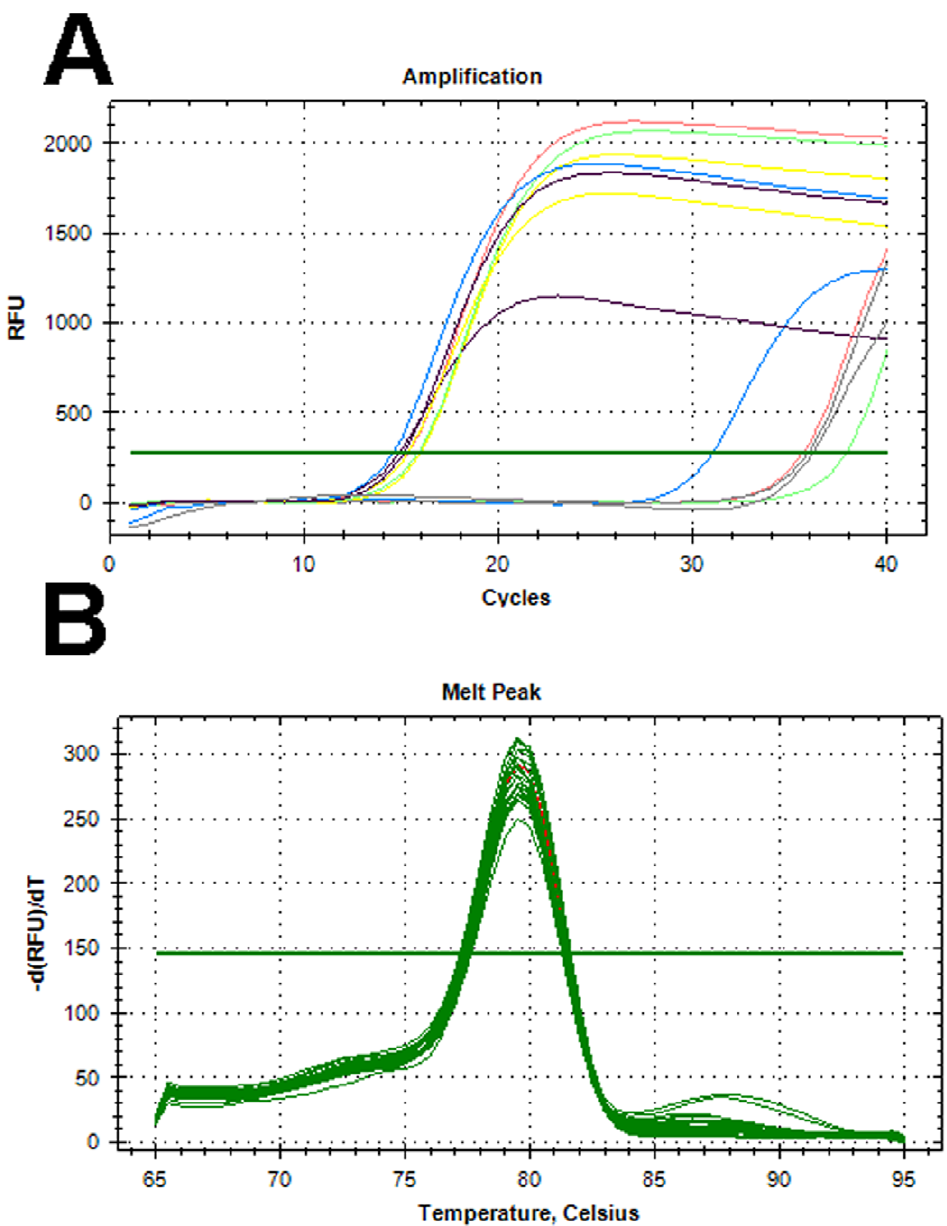
Figure 1. Amplification and melting curves for selected isolates. ( A ) Amplification curves of three of the eight E. coli isolates that were uidA - negative, but yccT -positive; MRSN 1628 (Red line), MRSN 1681 (Blue Line), and MRSN 7544 (Green Line). MRSN 7851 (Yellow Line) was both uidA and yccT -positive. E.coli ATCC 35218 (Black line) was used as a positive control and K. pneumoniae ATCC 1706 (Grey Line) was used a negative control. Each amplification curve is one representative sample from quintuplicate experiments. ( B ) Melting curve analysis of the amplicons produced by the yccT primer pair from 30 clinical isolates of E. coli demonstrating a highly conserved sequence in all strains. Melting curve of the yccT amplicon from E. coli ATCC 35218 is shown in red. All 30 isolates represented diverse pulse-types as determined by PFGE. RFU - Relative Fluorescent Units; -d(RFU)dt – Relative change in RFU over time (in seconds).